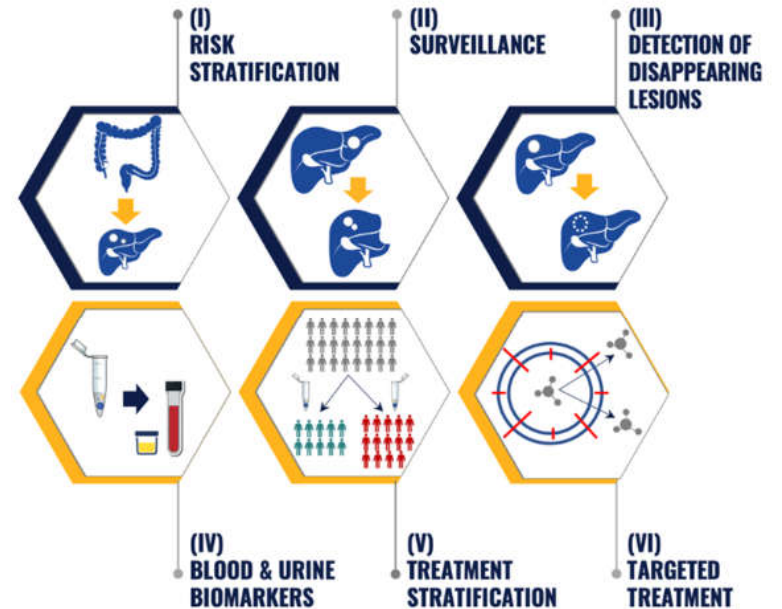
Figure 1. The potential clinical application of proteomic biomarkers in colorectal liver metastases (CRLM). ( I ) Risk stratification—assess the likelihood that CRLM will develop after oncologic resection of primary colorectal cancer (CRC). ( II ) Surveillance—early detection and treatment of recurrence after curative-intent resection of CRLM. ( III ) Detection of disappearing lesions—characterise the disease course and inform the surgical management of disappearing CRLM after preoperative systemic therapy. ( IV ) Blood and urine biomarkers—identify blood and urine biomarkers to monitor metastatic CRC progression and treatment. ( V ) Treatment stratification—predict response to multimodal therapy and select treatment that is most likely to yield a favourable response. ( VI ) Targeted treatment— patient selection for biomarker-driven clinical oncology